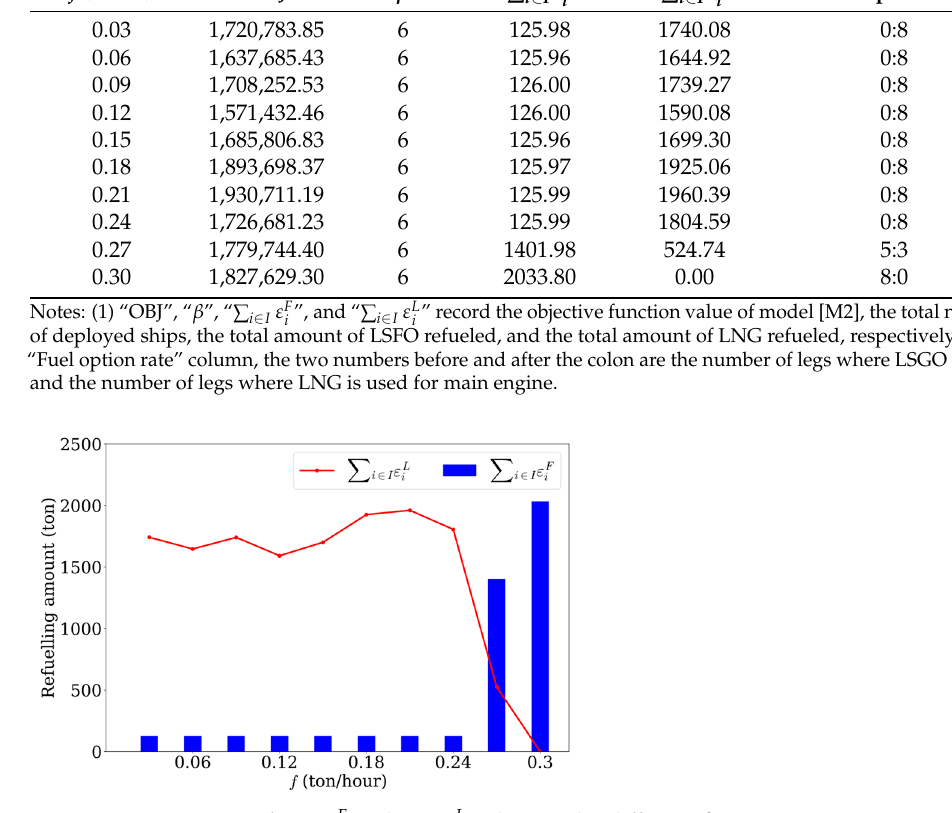
and ∑ i ∈ I ε L values under different f i i